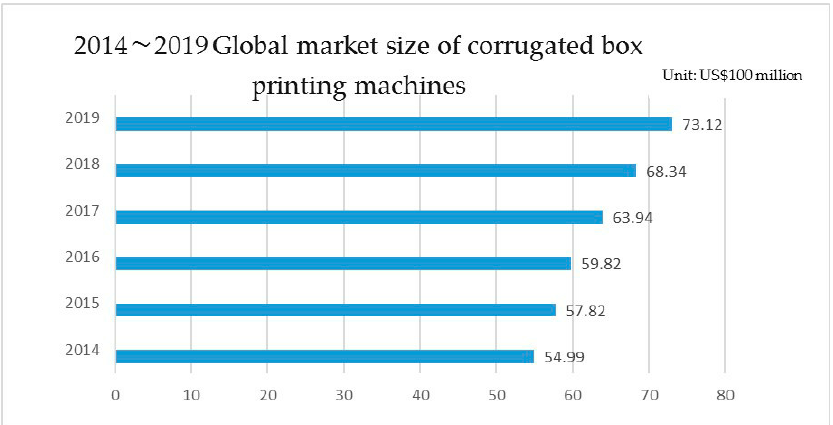
Figure 1. Global market size of corrugated box printing machines [4]